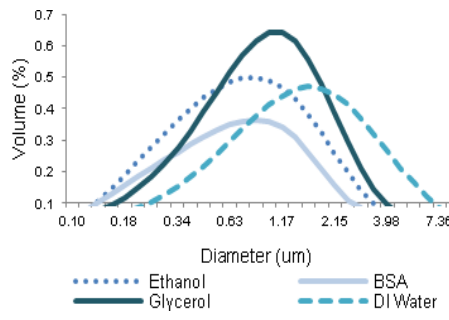
FIGURE 1: The comparison of droplet size distribution between various nebulised liquids at 13.33MHz and